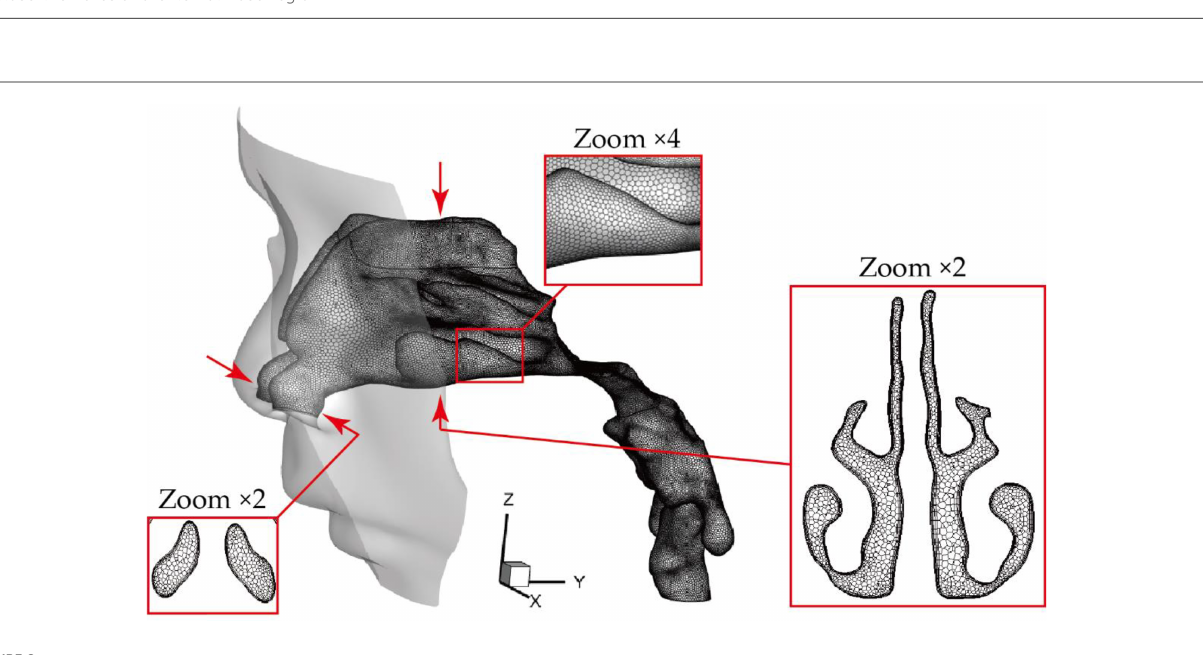
FIGURE 2 Preview of computational mesh (polyhedral mesh and prism